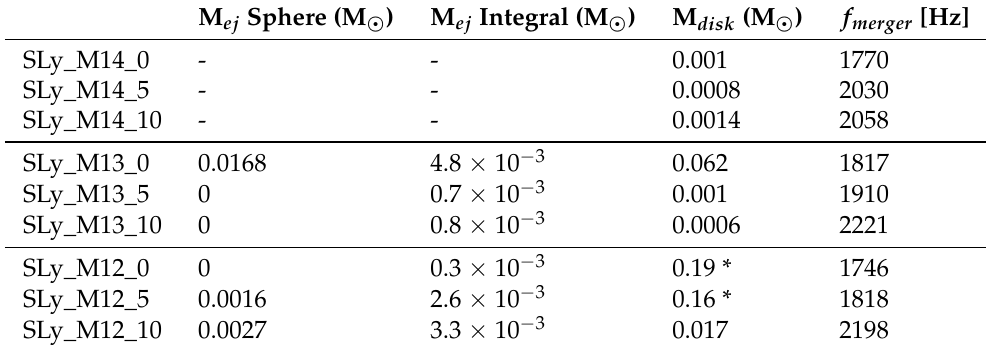
Table 4. First column: Name of the simulation. Second column: Total unbound matter flowed through a sphere with a radius of 450 km centered around the origin. The unbound matter is identified using the ballistic criterion, (see main text). Third column: Maximum value of the integral of unbound matter over the simulation domain reached during the simulation time. The unbound matter is again identified using the ballistic criterion. lFourth column: Mass of the disk at 5 ms after the merger was identified as the total bound mass outside a radius of 12 km from the center. Fifth column: Frequency of the (cid:96) = | m | = 2 mode of the gravitational waveform taken at the merger, i.e., the time of the GW strain maximum. * The disk of these simulations has been measured before the collapse of the remnant. Therefore, it can be affected by a higher uncertainty due to the ambiguity in the definition of the